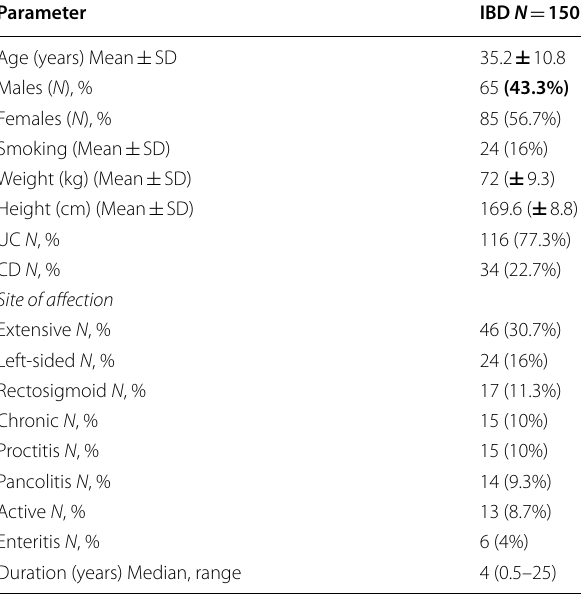
Table 1 Patients characteristics